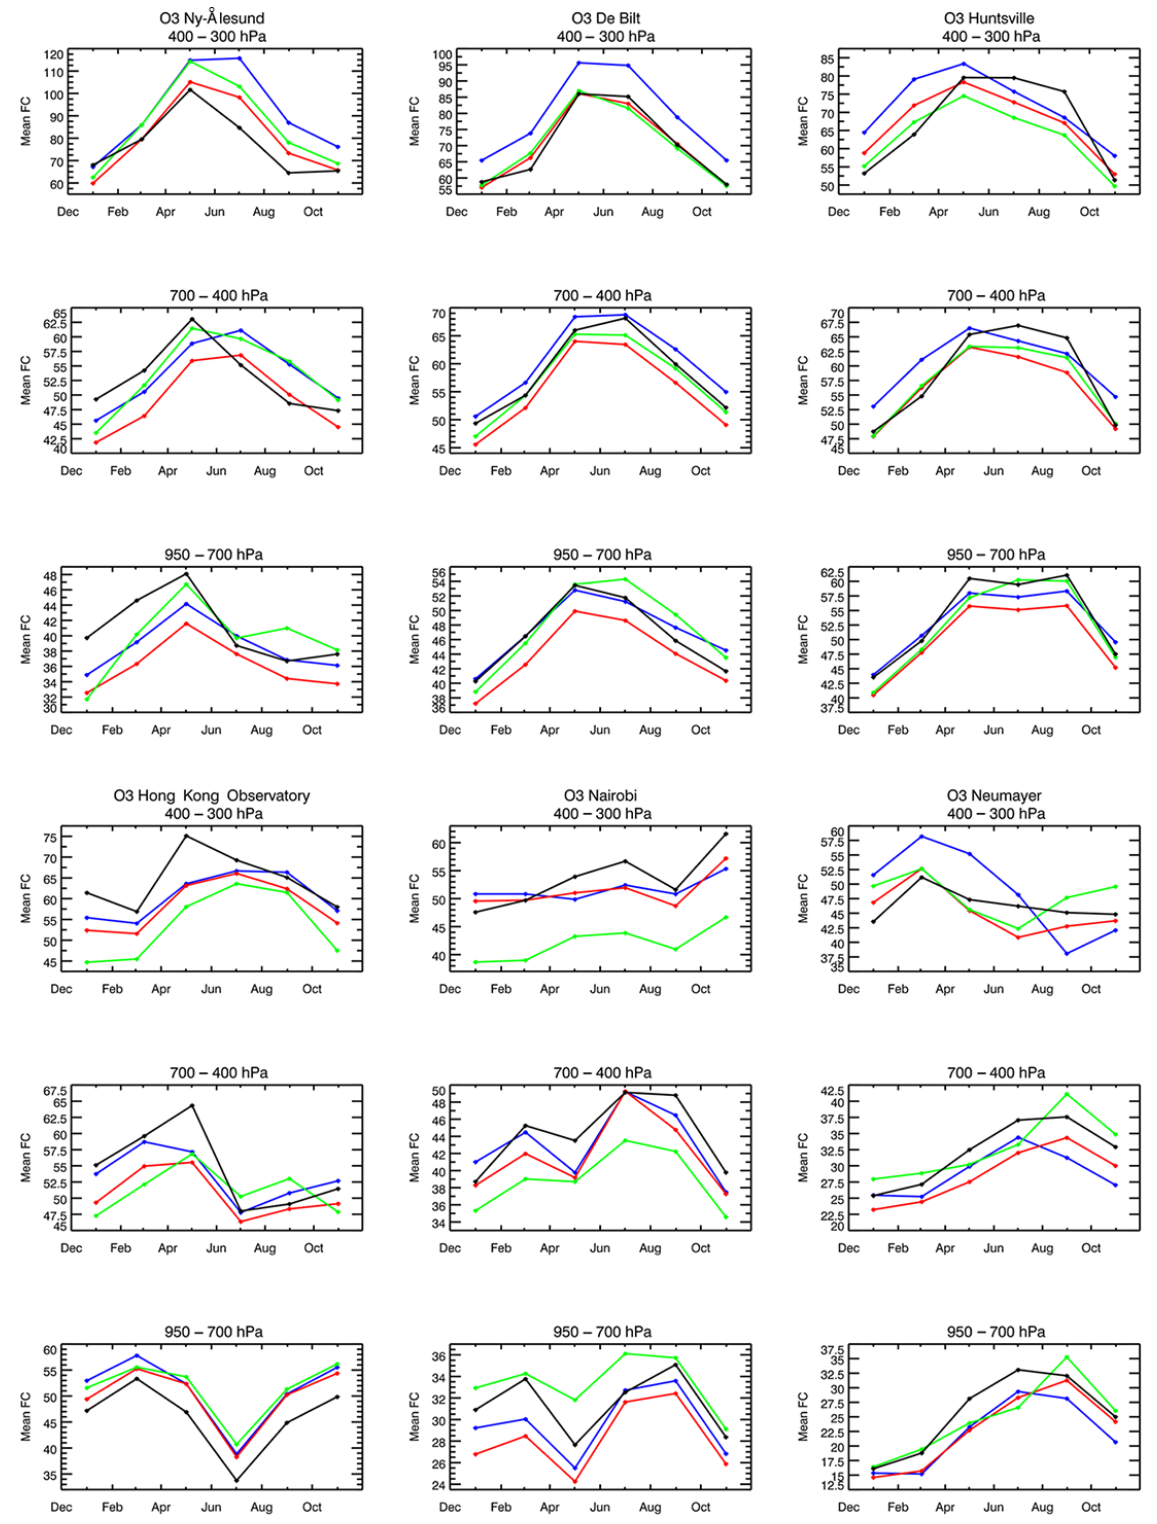
Figure 22. Time series of seasonal mean ozone bias inppb in the pressure ranges 950–700, 700–400 and 400–300hPa compared with ozone sondes at Ny-Ålesund, De Bilt, Huntsville, Hong Kong Observatory, Nairobi and Neumayer Station for CAMSiRA (red), the CR (blue) and MACCRA